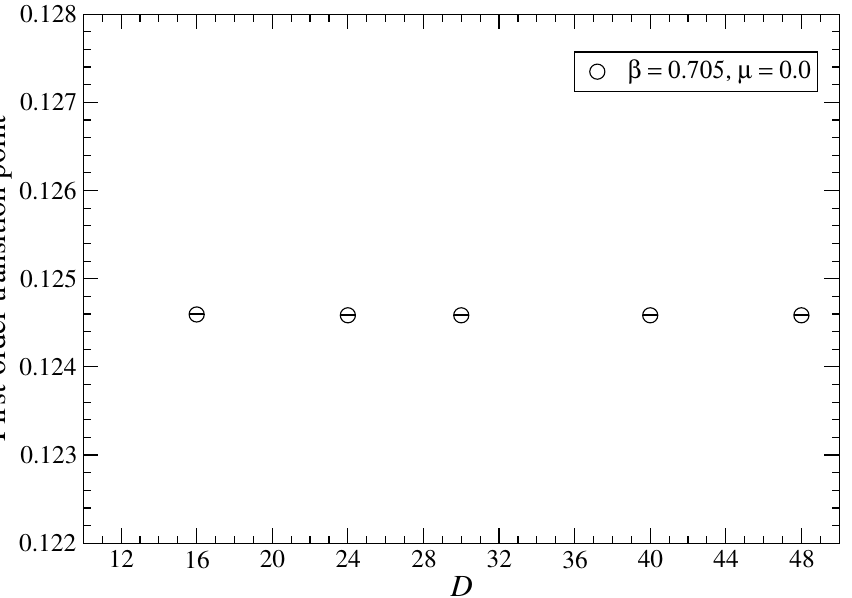
Figure 4 . Convergence behavior of the transition point of η as a function of D at β = 0 . 705 with vanishing µ . Error bars are all within the symbols.